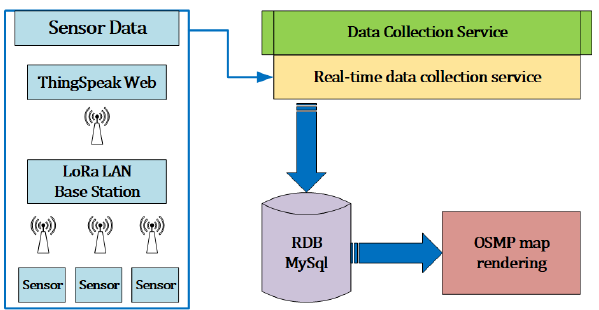
Figure 3. Data Collection